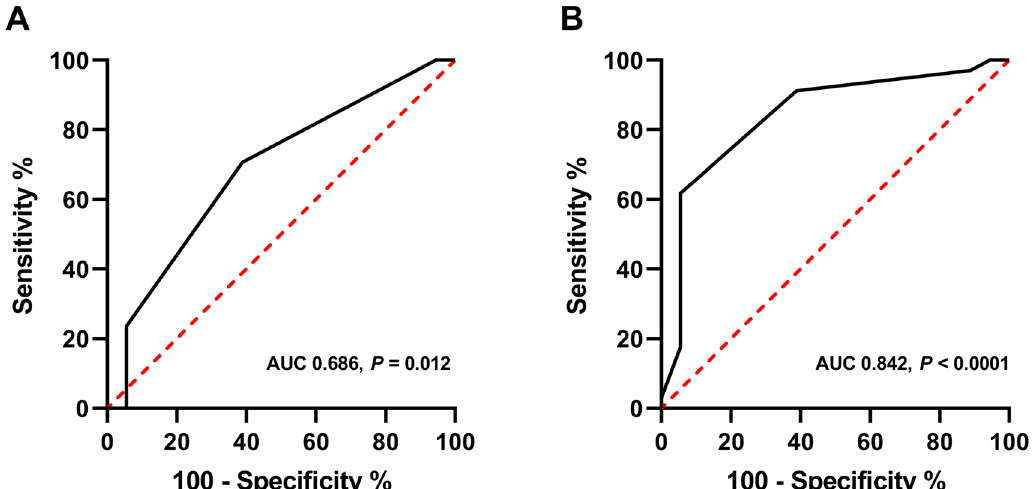
Figure 3. Receiver operating characteristic (ROC) curve analysis of the bone scan scoring system to determine the optimal cut-off values for identifying unstable thoracolumbar burst fractures. B B ≥ 3 and B TS ≥ 4 were found to be the optimal cut-off values. ( A ) The area under the ROC curve (AUC) for B B was 0.686 (95% confidence interval, 0.543 – 0.808). ( B ) The AUC for B TS was 0.842 (95% confi- dence interval, 0.714 – 0.928).